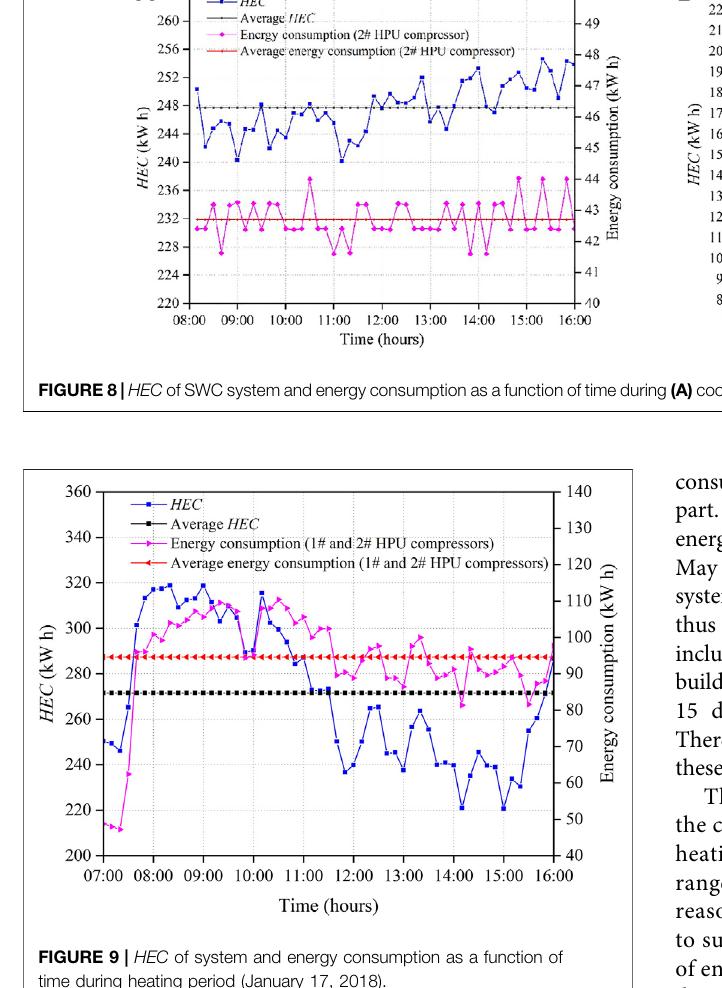
Frontiers in Earth Science |